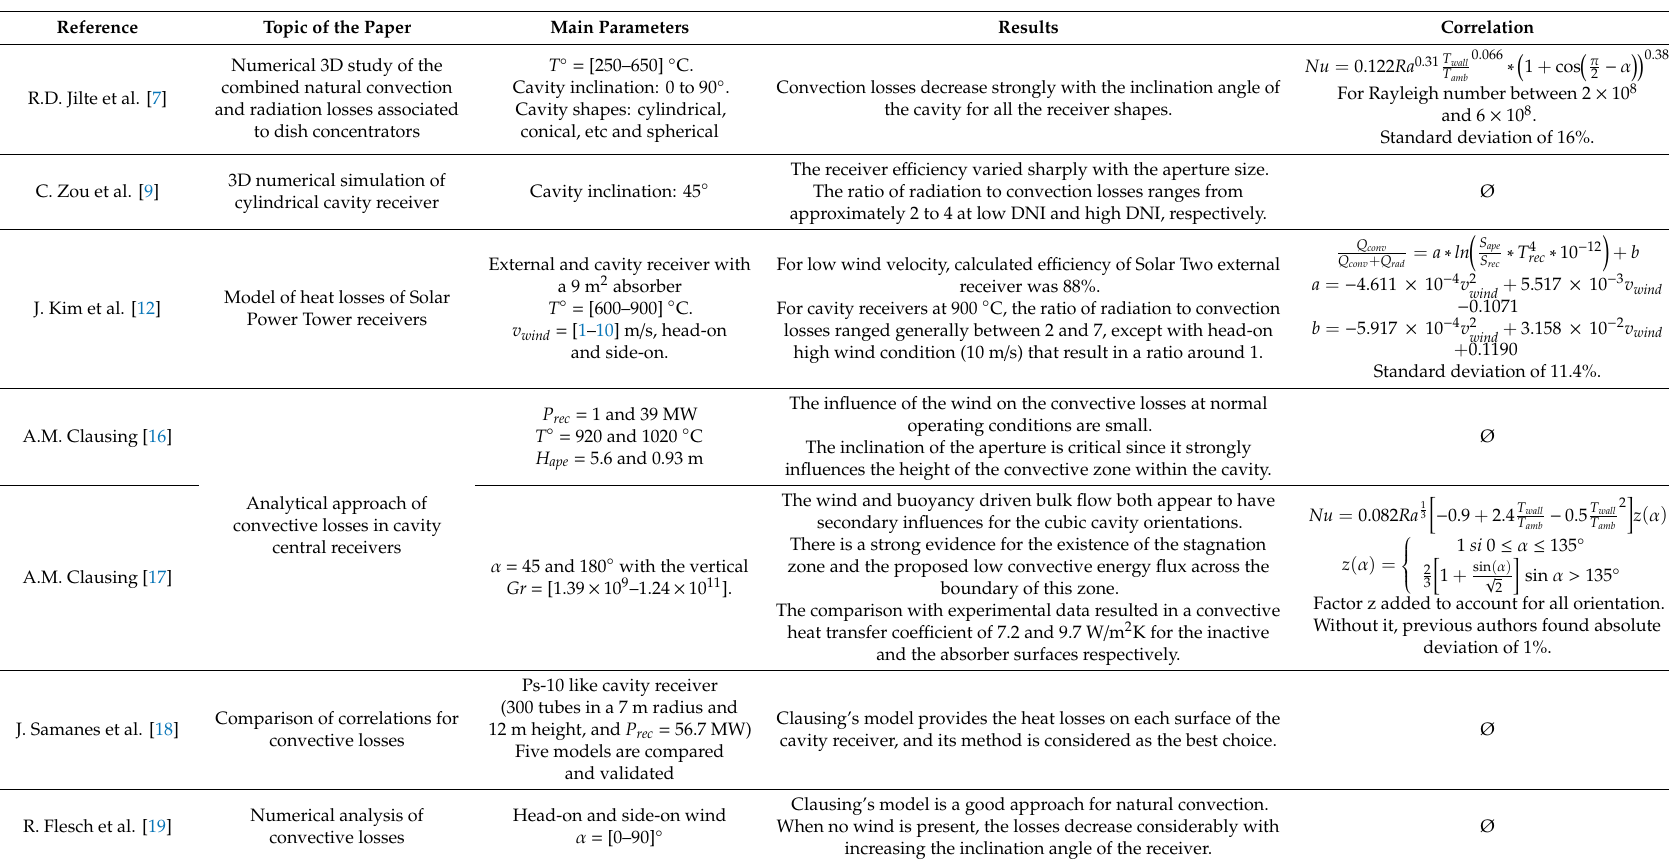
Table A1. List of references of convective losses studies in cavity